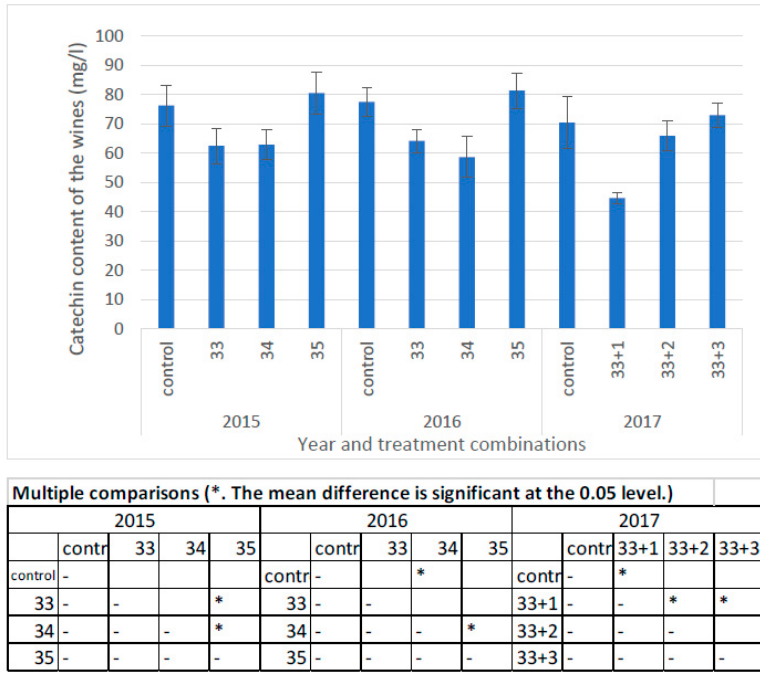
Figure 9. Catechin content of the wines in 2015–2017 (mg/L).